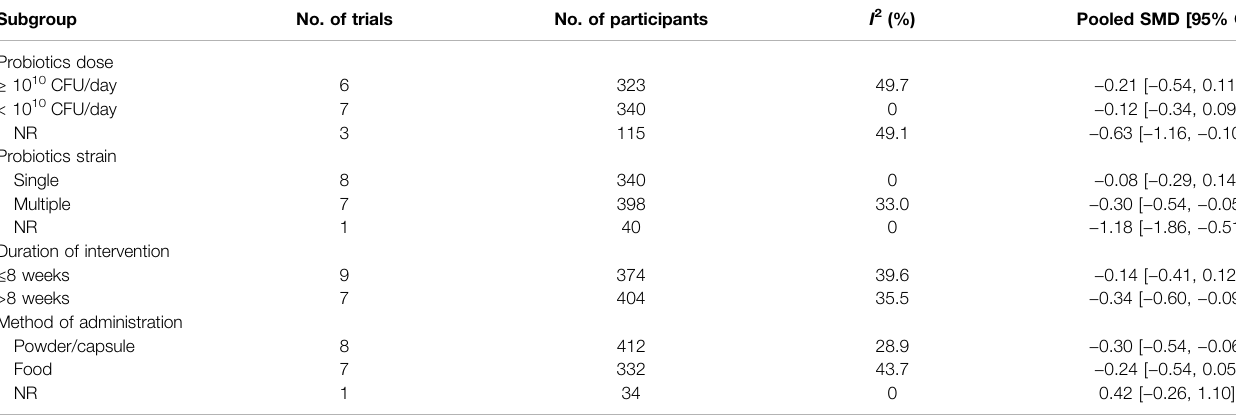
TABLE 5 | Subgroup analysis for the effects of probiotics on FPG.